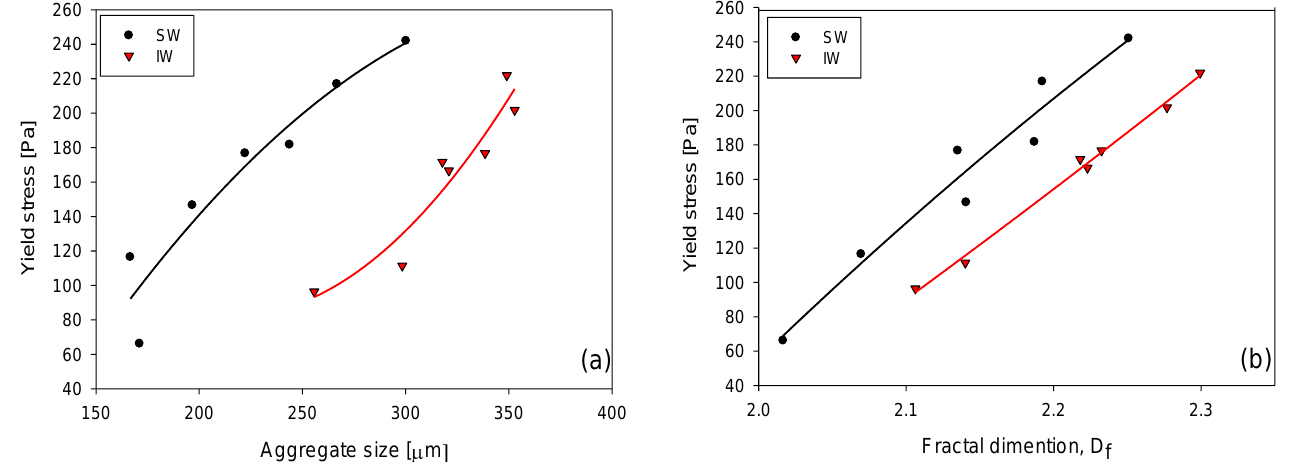
Figure 9. Relationship between sediment yield stress and ( a ) aggregate size (mean chord length) and ( b ) fractal dimension in IW and SW. Shear rate 180 rpm, solid concentration 5 wt%, flocculation time 15 s, and pH 7.